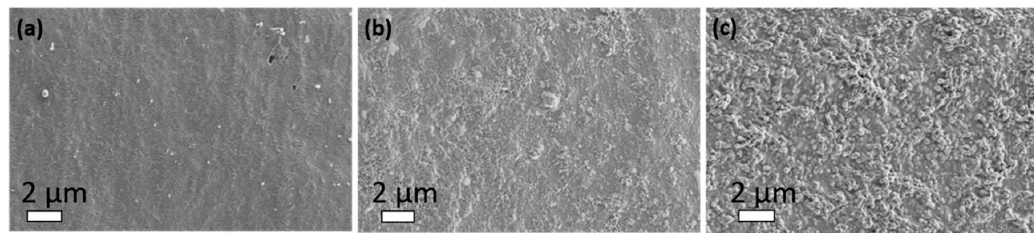
Figure 5. Scanning electron microscopy ( SEM) images of the pristine whey protein-based layer as the inner layer of the laminate ( a ); the whey-based laminate treated with 2% CS+CSNPs CIN ( b ); the whey-based laminate treated with 2% CS+CSNPs ROS ( c ). Note that all the images are taken at 10,000× magnification for easier comparison.